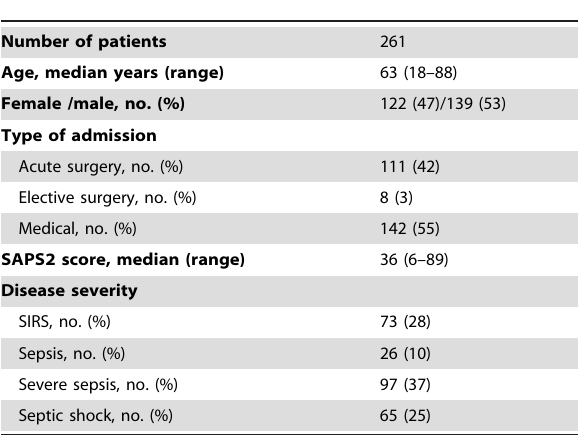
Table 1. Demographics of the patients.